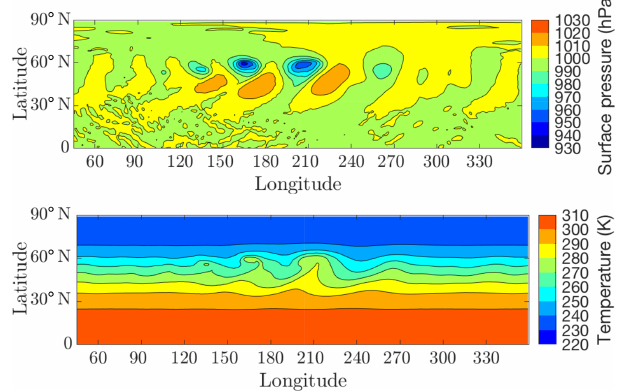
Figure 8. Latitude–longitude projections of surface pressure and temperature at vertical level 4 (about 867hPa) of the adaptive sim- ulation of the baroclinic instability test case at day